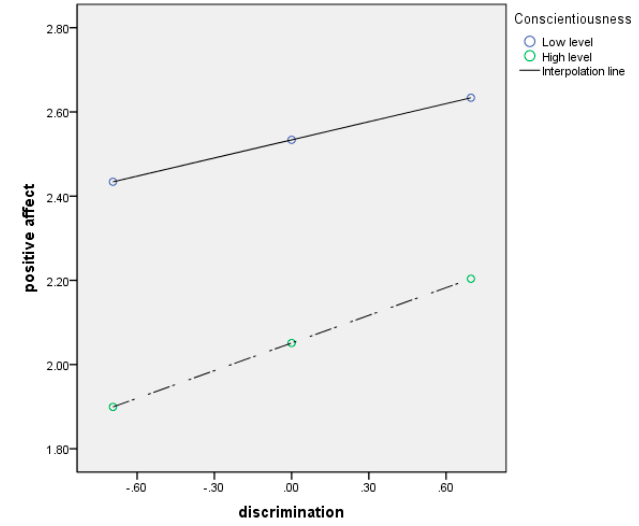
Figure 3. Moderating effects of conscientiousness in predicting positive affect.